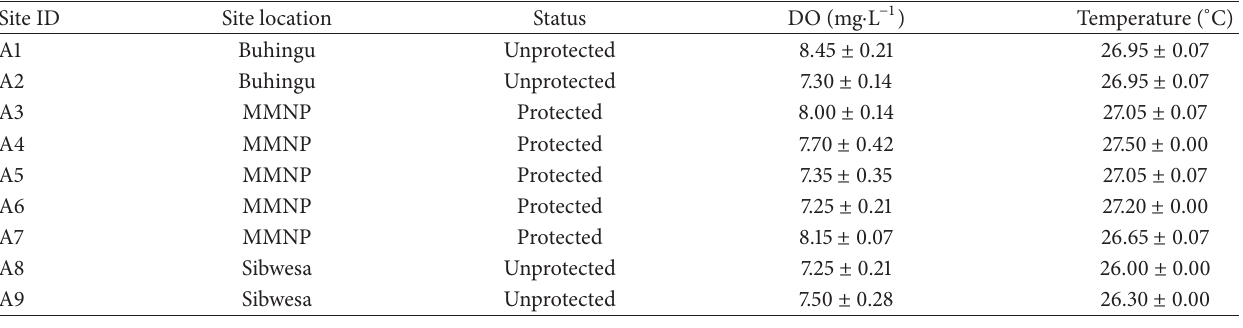
Table 1: Environmental parameters mean ( ± SD) of study sites in protected and unprotected areas in Lake Tanganyika, Tanzania, from gillnet survey during 2008. Samples from site A4 were omitted in the analysis.